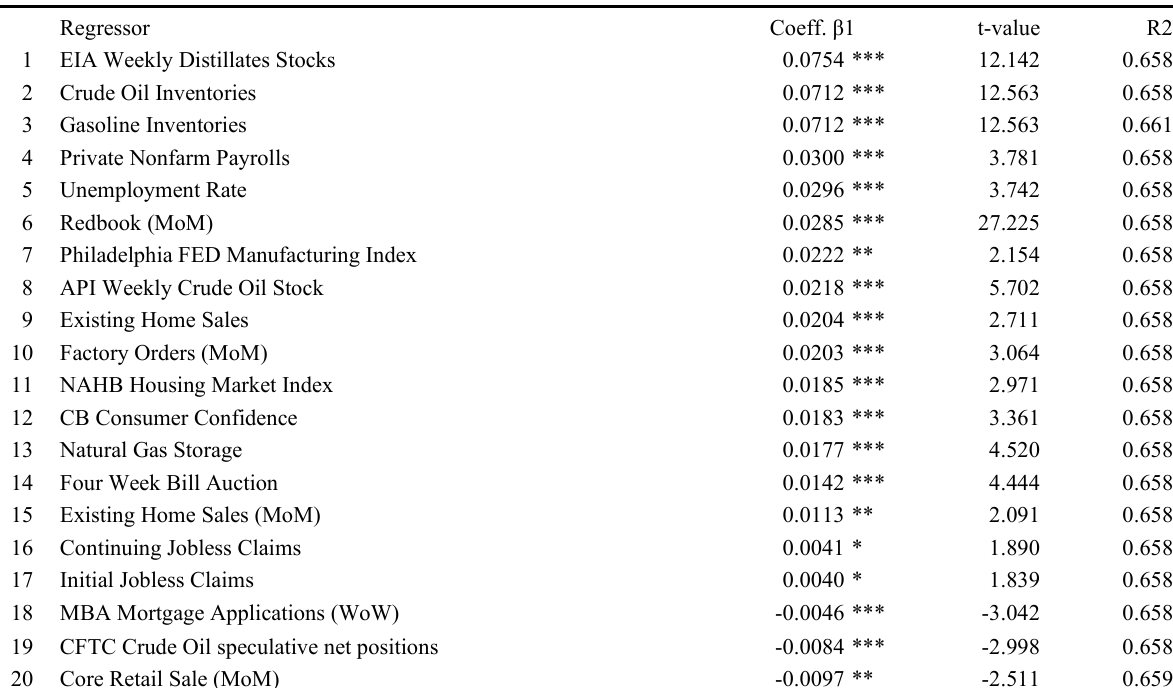
Table 2: Ranking of Significant US News Announcements on Brent Crude Oil, Simple Autoregressive OLS